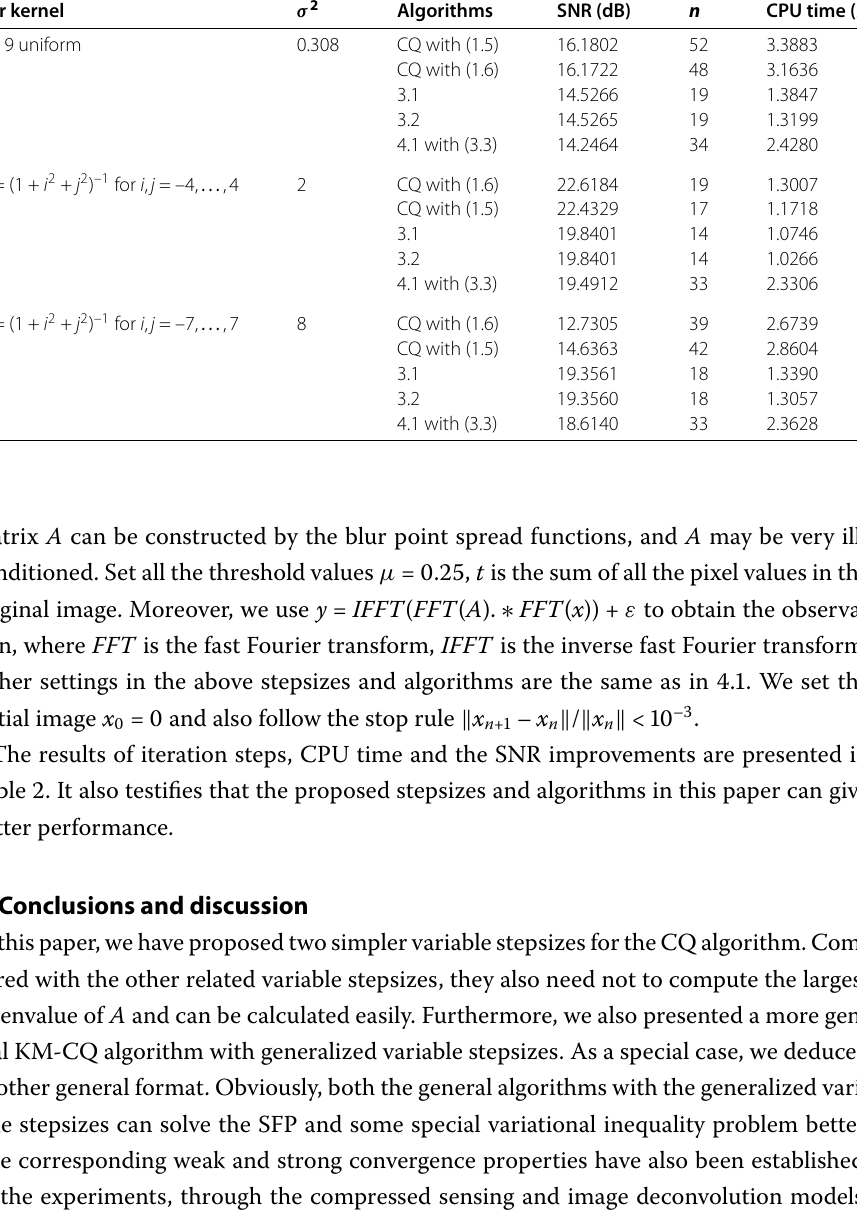
Table 2 Results for the restorations of different stepsizes and algorithms Blur kernel σ 2 Algorithms SNR (dB) n CPU time (s) 9 × 9 uniform 0.308 CQ with (1.5) 16.1802 52 3.3883 CQ with (1.6) 16.1722 48 3.1636